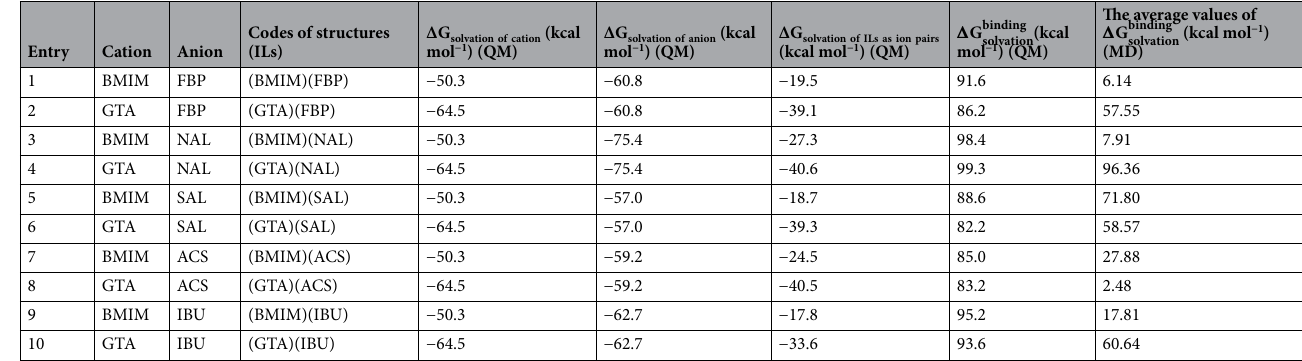
Table 4. ΔG solvation of cation , ΔG solvation of anion and ΔG solvation of ILs as ion pairs (kcal/mol) of ILs calculated at B3LYP/6- 311++G(d,p) level and comparison between (cid:31) G from MD